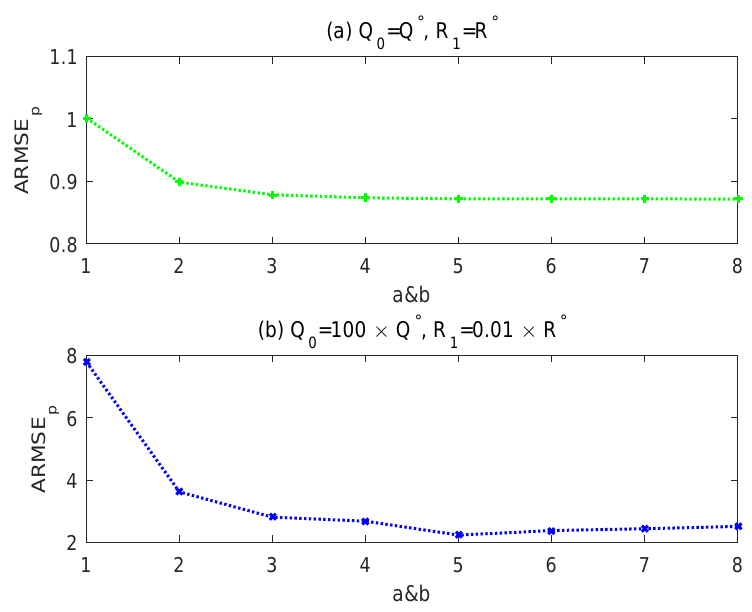
Figure 1. ARMSE p results of different weighting parameters in two different